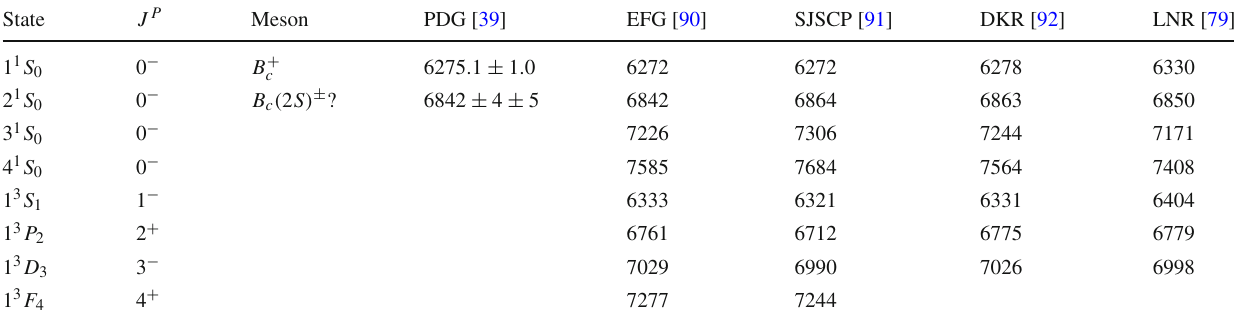
Table 6 Masses of the bottom mesons (in MeV). The experimental data are from PDG [39]. The theoretical values are from EFG [16],KDR [87], LNR [60] and AMSAS [88]. ? denotes the possible candidates for the unwell-established states or the mesons needing